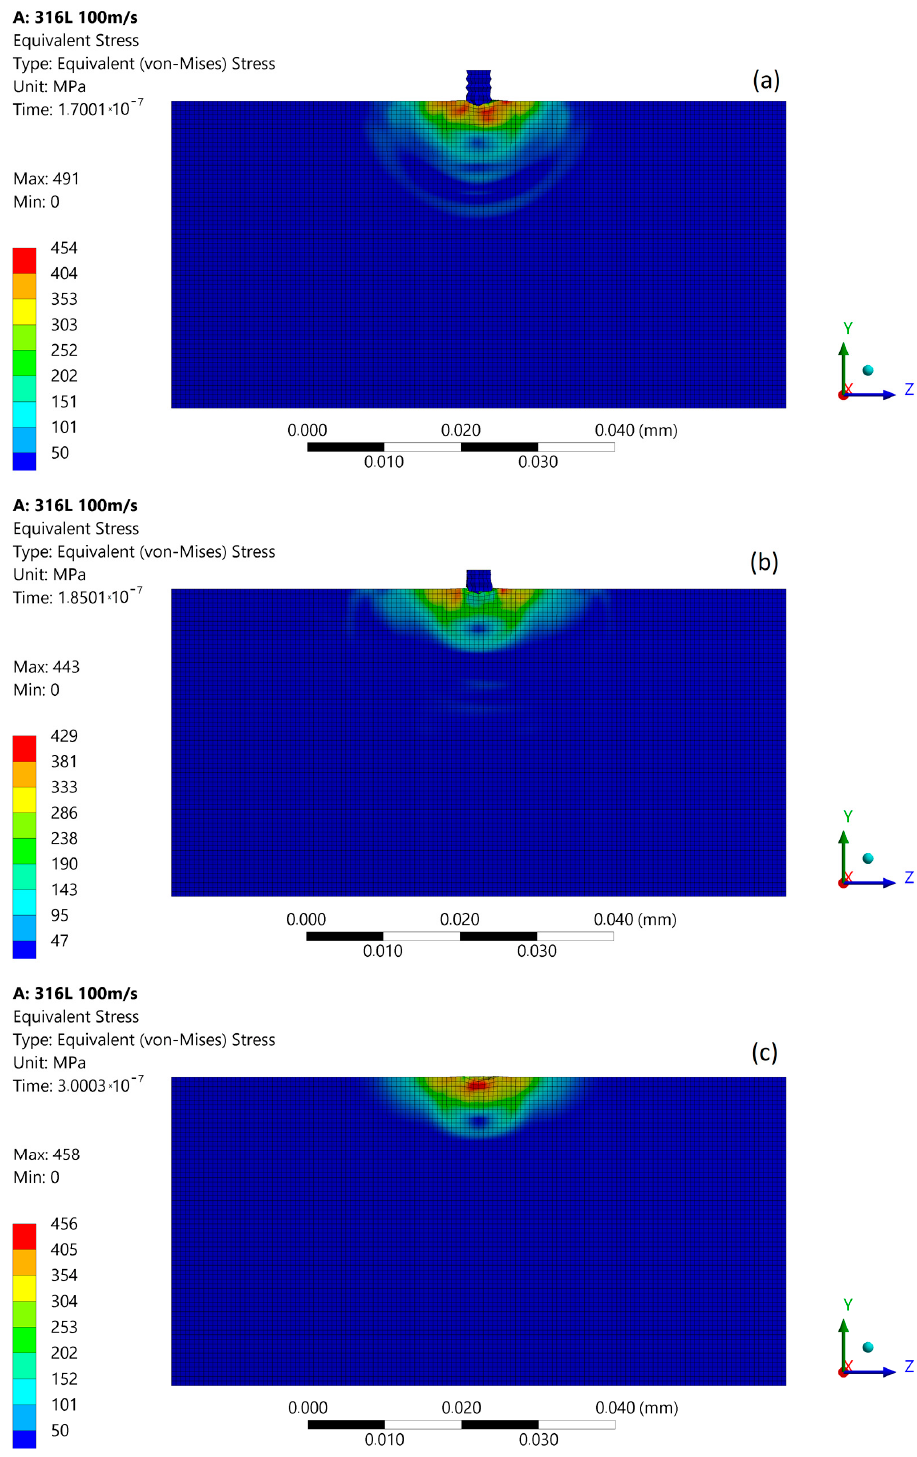
Figure 7. Von Mises stress distribution during subsequent micro ‐ jet impact at 100 m/s: ( a ) initial stage of the impact; ( b ) stage during the impact; ( c ) residual stress after the impact. The simulation results obtained for the micro ‐ jet impact at 100 m/s are most closely related with experimental results after 600 kPa exposition located in the slightly eroded